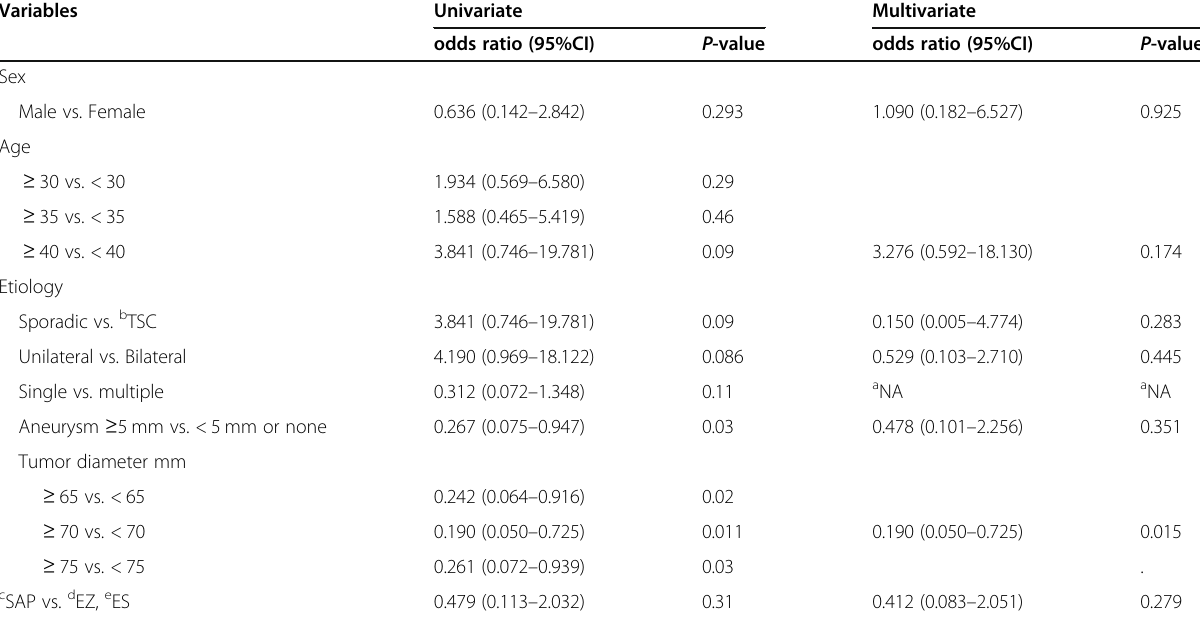
Table 3 Univariate and multivariate analyses Variables